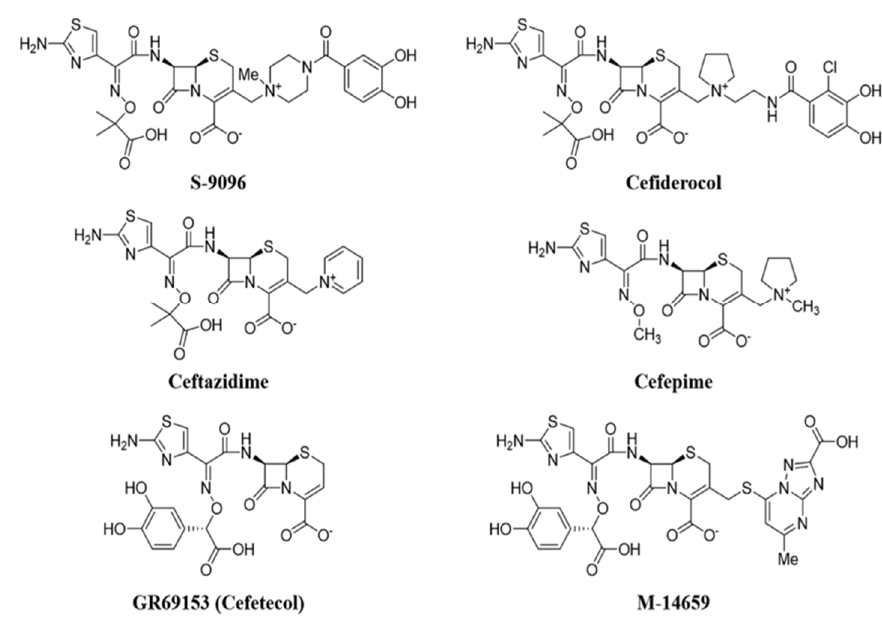
Figure 9. Structures of different cephalosporins conjugated with siderophores.